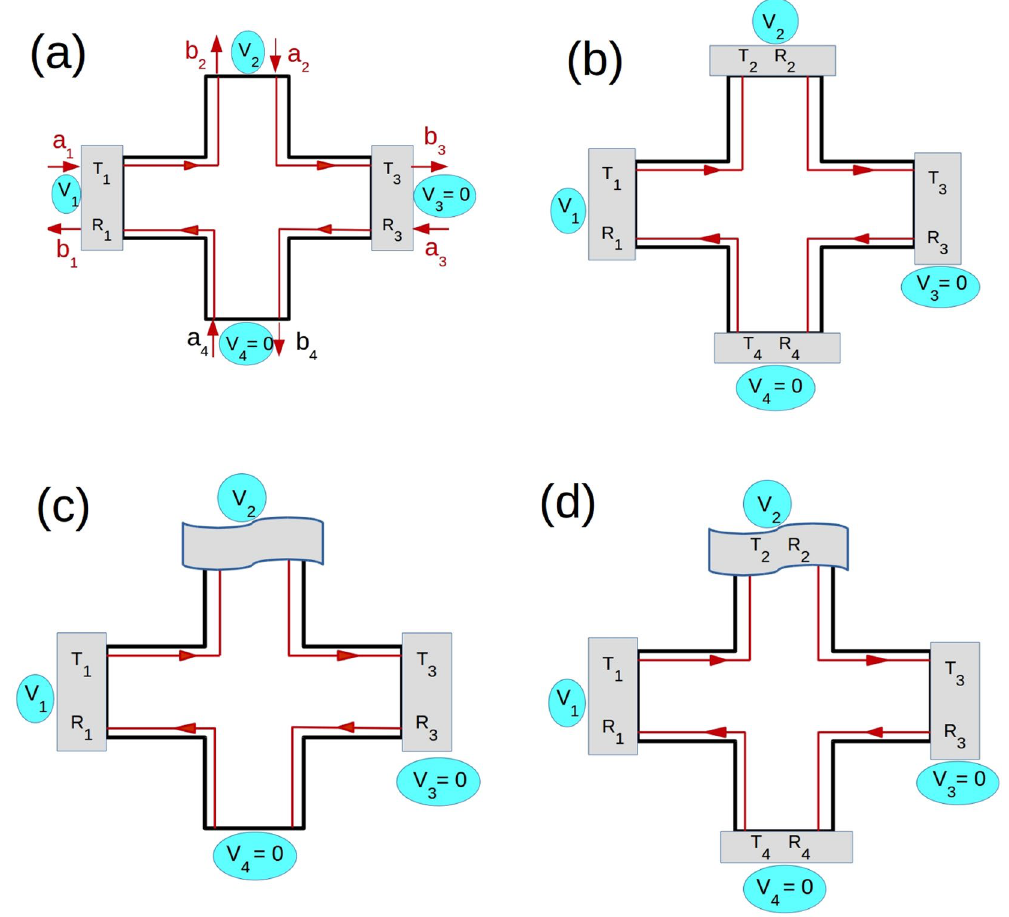
Figure 2. The QH setup, probes 3 and 4 are detectors kept at zero potential, a voltage is applied only to probe 1, ( a ) QH bar with two disordered probes (potential at probe 2 = 0), a i ’s and b i ’s with i = 1–4 are the incoming and outgoing waves at the probes, ( b ) QH bar with all disordered probes, ( c ) QH bar with two disordered probes and inelastic scattering- probe 2 (curvy box) is a voltage probe (with current into it I 2 = 0), ( d ) QH bar with all disordered probes and inelastic scattering- probe 2 (curvy box) is a voltage probe (with current into it I 2 = 0). To avoid clutter the waves are only shown in ( a ). ( b – d ) Have exactly similar waves to and from the probes, these aren’t shown